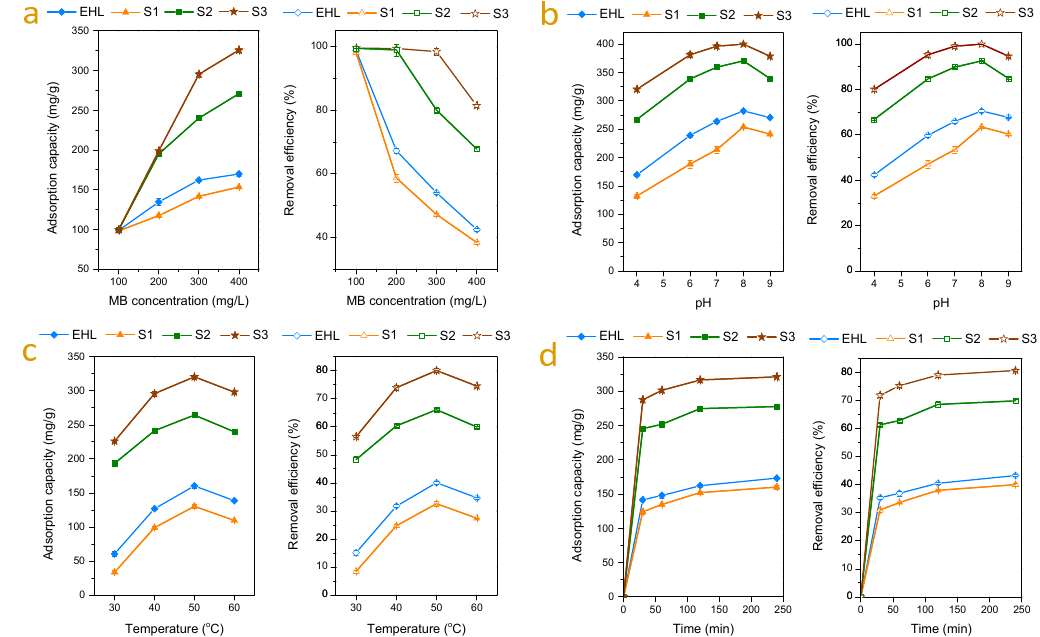
Figure 4. Methylene blue (MB) adsorption on EHL and its three subdivisions: ( a ) effect of MB concentration on adsorption capacity and removal efficiency (lignin concentration 1000 mg/L, temperature 50 °C, time 120 min, and pH value 4.0); ( b ) effect of pH (lignin concentration 1000 mg/L, MB concentration 400 mg/ml, temperature 50 °C and time 120 min); ( c ) effect of temperature (lignin concentration 1000 mg/L, MB concentration 400 mg/L, time 120 min, and pH value 4.0); ( d ) effect of time (lignin concentration 1000 mg/L, MB concentration 400 mg/L, pH value 4.0, and temperature 50 °C).